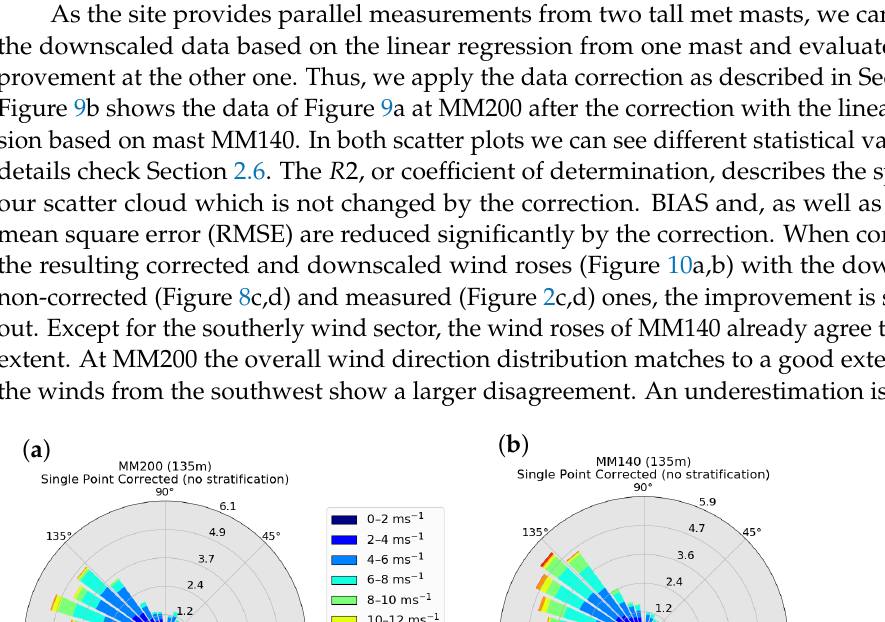
Figure 9. Scatter plots between measurements and downscaled data: ( a ) MM200 downscaled data, and ( b ) MM200 corrected (based on regression at MM140; exemplary for single point downscaling).